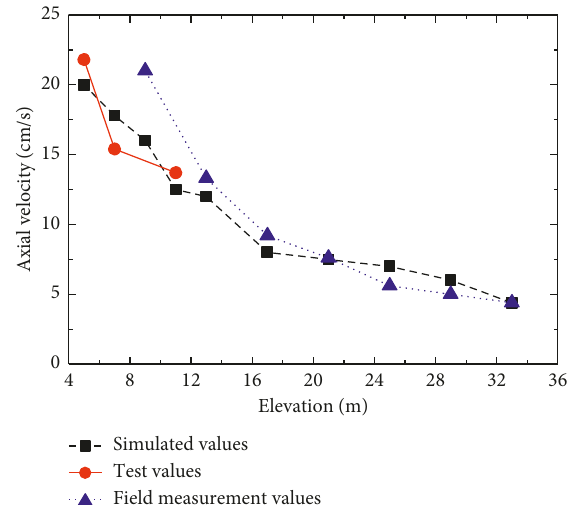
Figure 6: Axial vibration velocity comparison among molds of the shaft